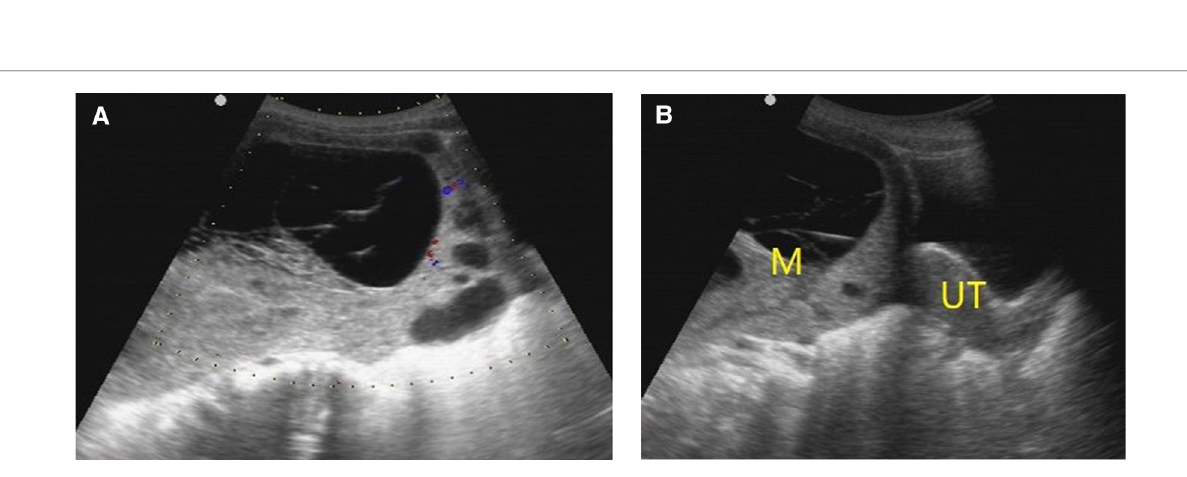
FIGURE 3 O-RADS 3, maximum diameters of lesion 93 mm, pathology: serous cystadenoma. ( A ) Multilocular cyst, no solid elements, color score 2; ( B ) The mass was located on the left side of the uterus. M, mass; UT, uterus.